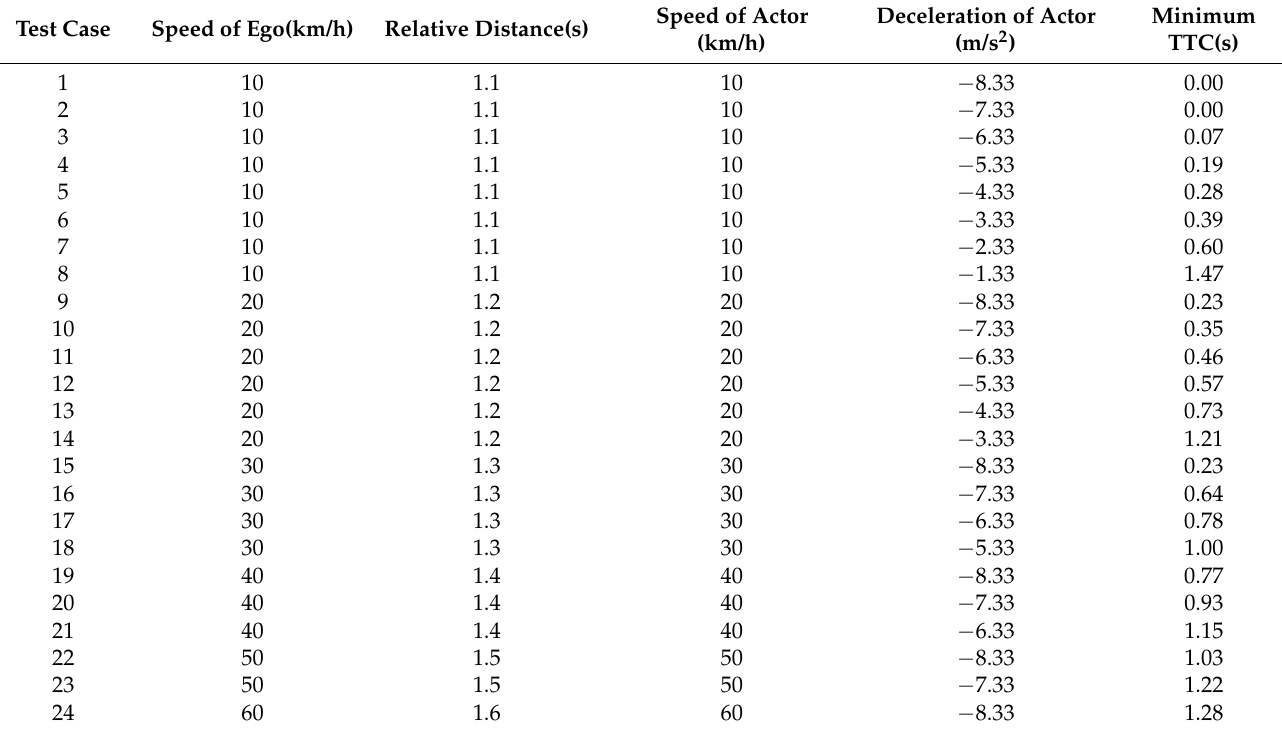
Table 5. Test case generation result.